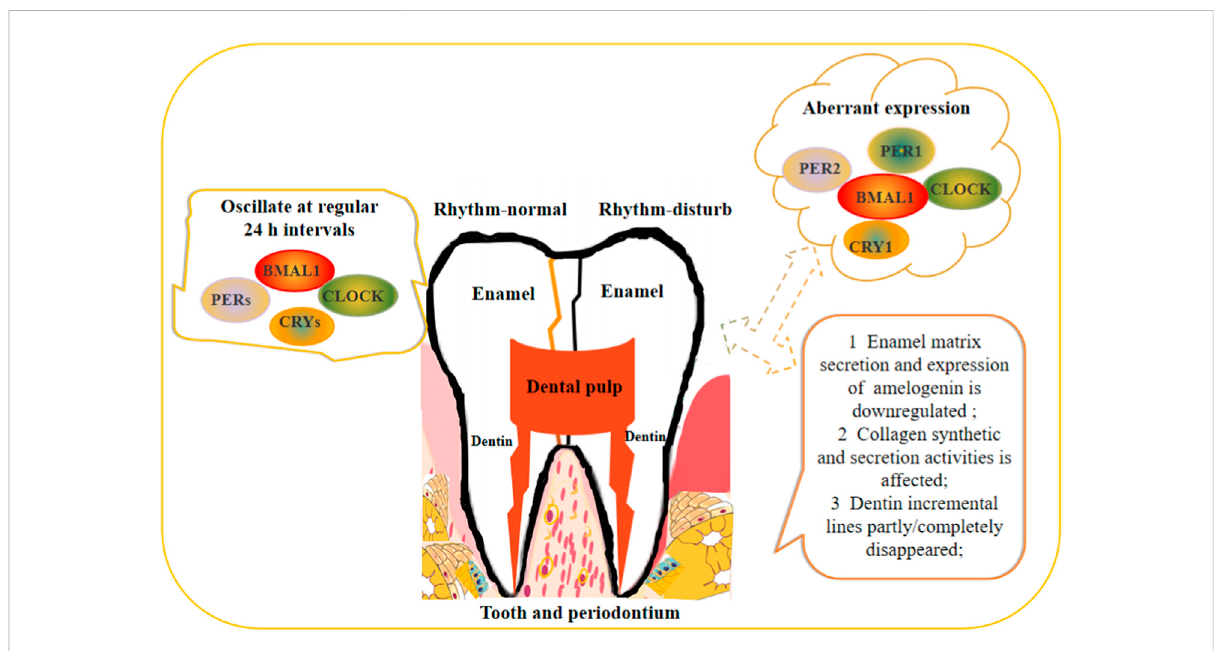
FIGURE 2 Schematic illustration of circadian rhythm regulates the teeth